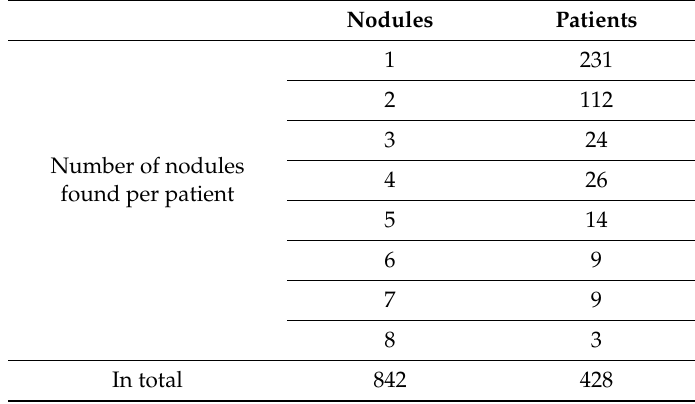
Table 1. Distribution of the number of nodules per patient, reflecting the degree of multinodularity.